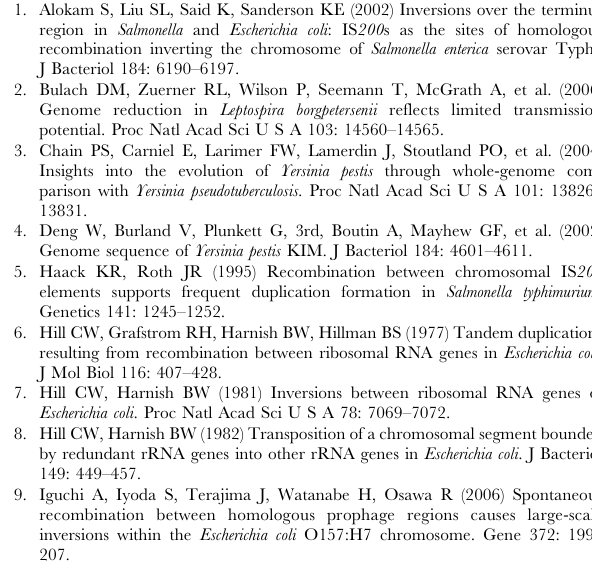
Table S2 Estimated Replichore Length and Balance of Theortetical Arrangement